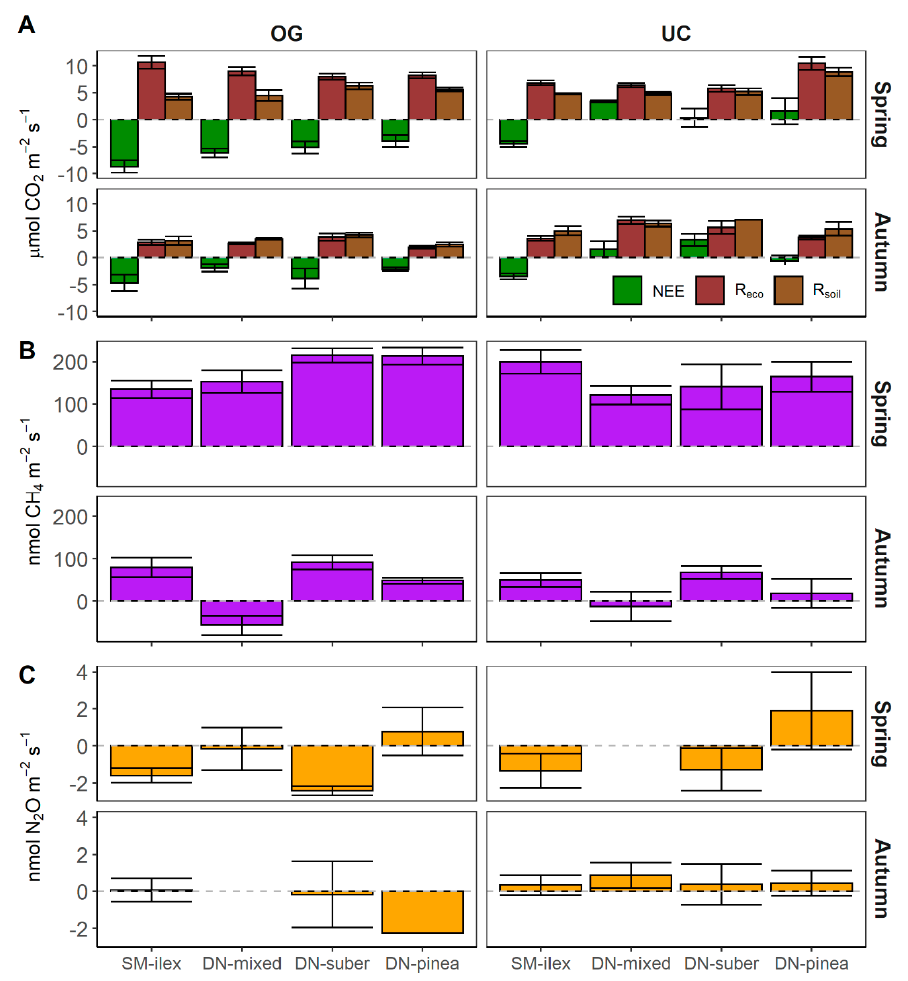
Figure 1. Greenhouse gas exchange per plot, season, and canopy: open grassland (OG) and under the canopy (UC). ( A ) Net ecosystem CO 2 exchange (NEE, green), ecosystem respiration (R eco , garnet), and soil respiration (R soil , brown); ( B ) CH 4 (purple); and ( C ) N 2 O (yellow) exchange. Mean ± standard error. Thus, the canopy itself had a strong influence over CO 2 fluxes. Generally, NEE under the canopy was dominated by CO 2 emissions (canopy effect, t = 5.58, p < 0.001, Table 2), NEE being strongly driven by PAR (PAR e ff ect, t = − 4.58, p < 0.001, Table 2). The exception was the SM ‐ ilex plot, where there was net CO 2 uptake under the canopy, instead of emis ‐ sions (NEE, Figure 1A). On the other hand, R eco decreased under the canopy compared to the open grassland in spring but increased under the canopy in autumn (season x canopy effect, t = 4.73, p < 0.001, Table 2). R soil increased under the canopy, especially in autumn (season x canopy effect, t = 2.40, p = 0.02, Table 2), R soil being enhanced by T a (T a effect, t = 3.06, p = 0.003, Table 2) and BGB (BGB effect, t = 2.21, p = 0.03, Table 2).